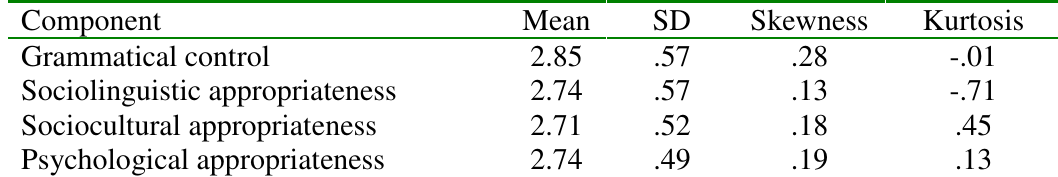
Descriptive Statistics for the Four Language Knowledge Components (N =